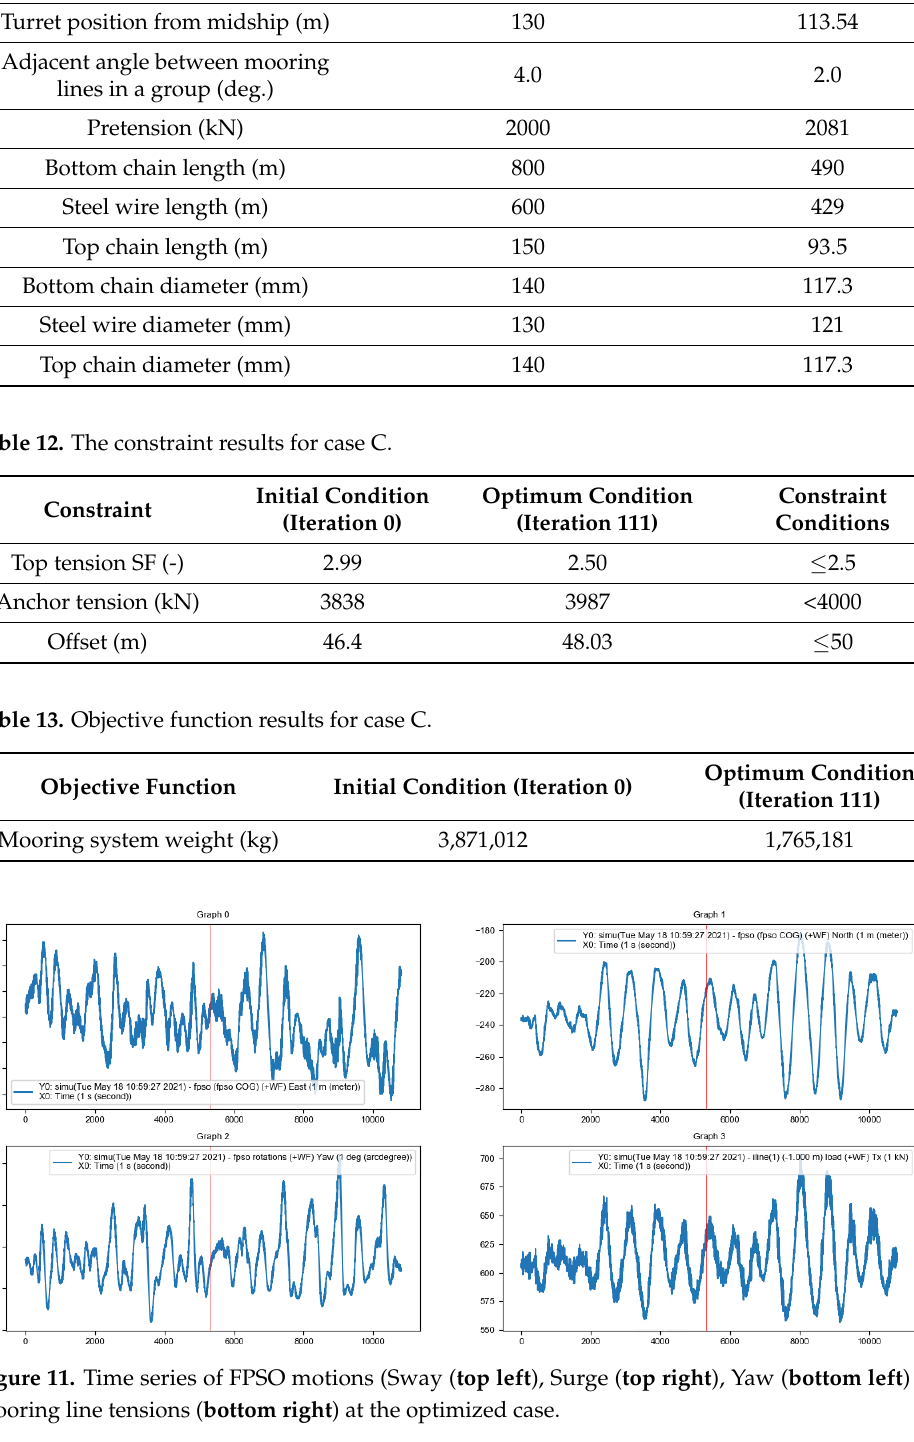
Table 11. The results of mooring the system optimization for case C.